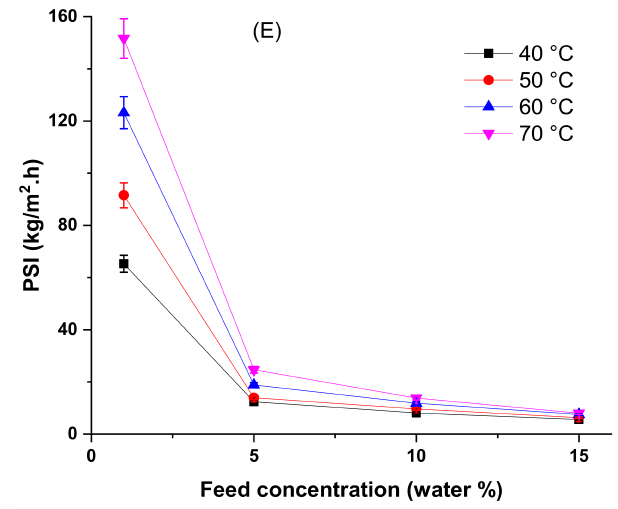
Figure 4. Methanol dehydration performance of PVA10 membrane at a di ff erent temperature as a function of feed water concentration vs. ( A ) total flux, ( B ) separation factor, ( C ) water and methanol fluxes (continuous line water flux; dotted line methanol flux), ( D ) water permeate concentration, and ( E ) pervaporation separation